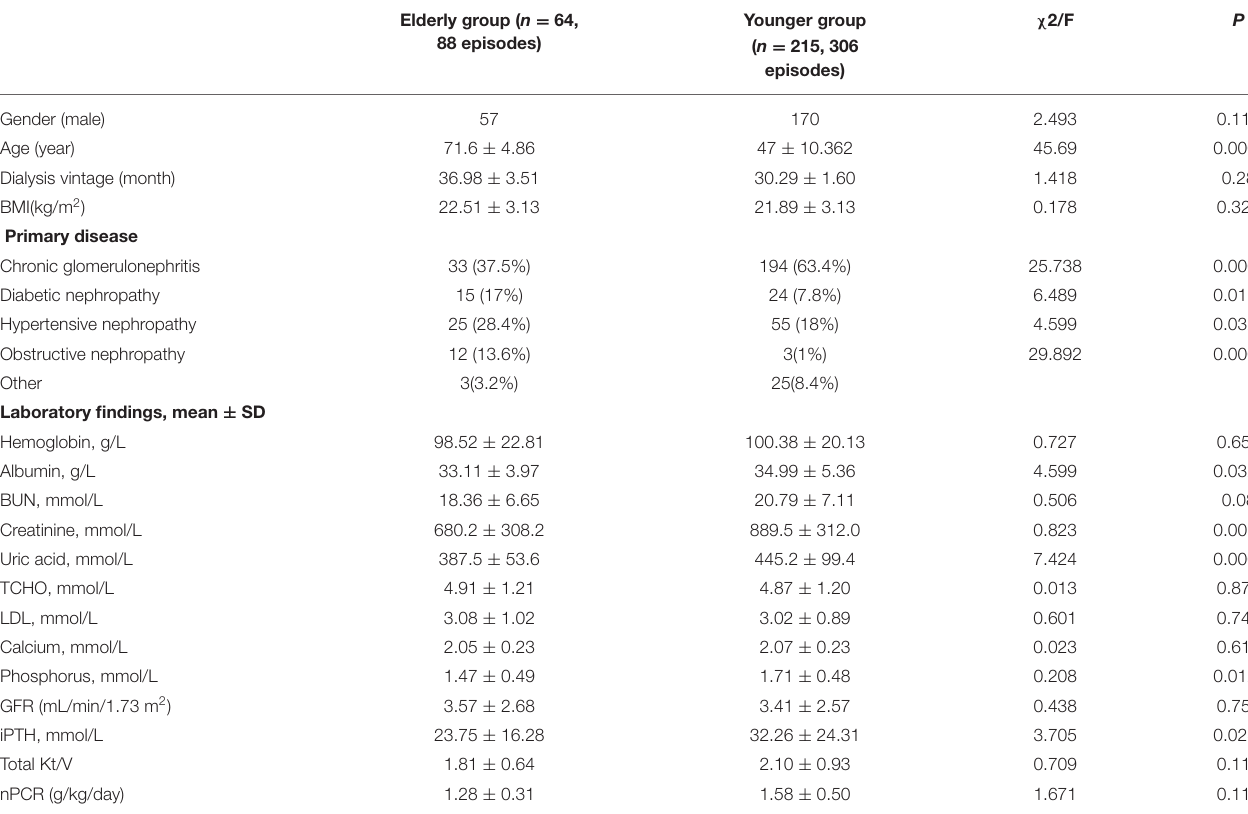
TABLE 1 | Baseline characteristic of the study